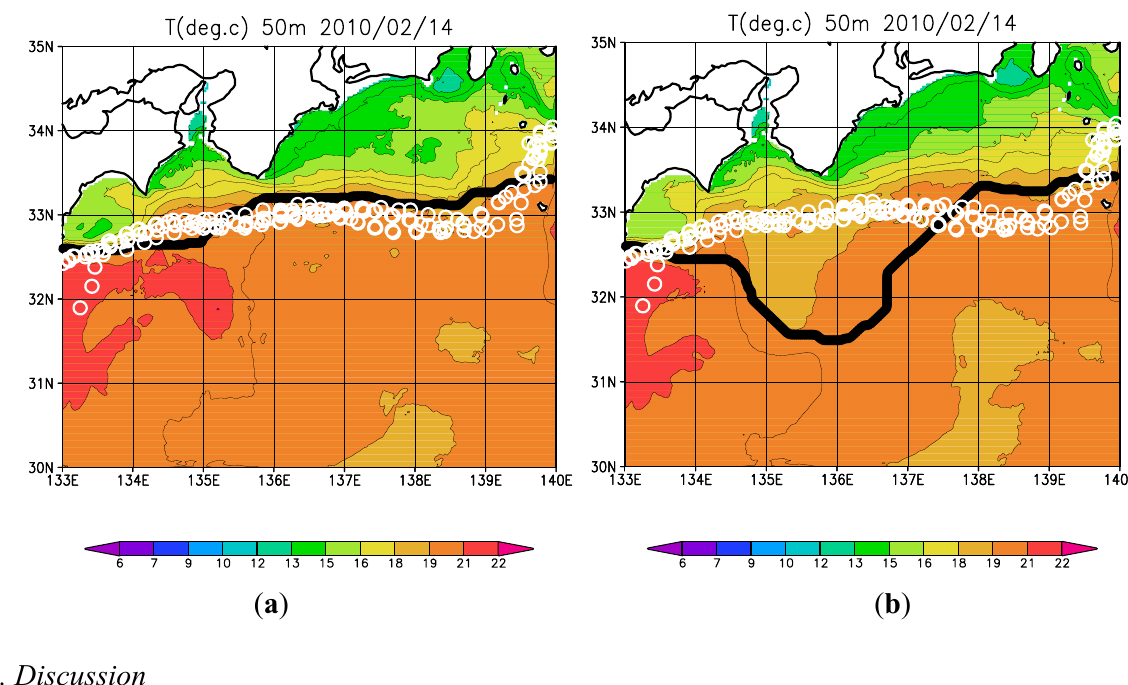
Figure 9. Ensemble mean analysis temperature at 50 m depth (shade and contours) on 14 February 2010. ( a ) dqc.m1p2. ( b ) NO-SSHA. Thick contours denote the Kuroshio path positions evaluated from the ensemble mean flows at 50 m depth by tracking grids with the strongest kinetic energy at each longitude. Open circles represent the weekly mean observed path positions provided from the Japan Coast Guard. The duration of the weekly mean period was daily updated and then all position data including the target day in their weekly mean periods were